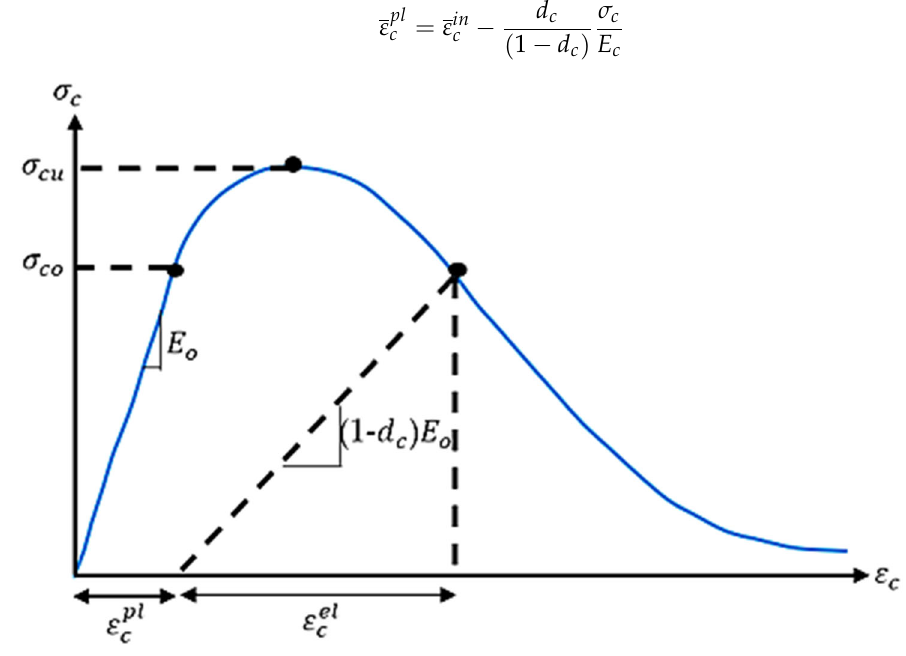
Figure 1. Stress ‐ strain relationship of concrete under the effect of compression stress. Figure 1. Stress-strain relationship of concrete under the effect of compression